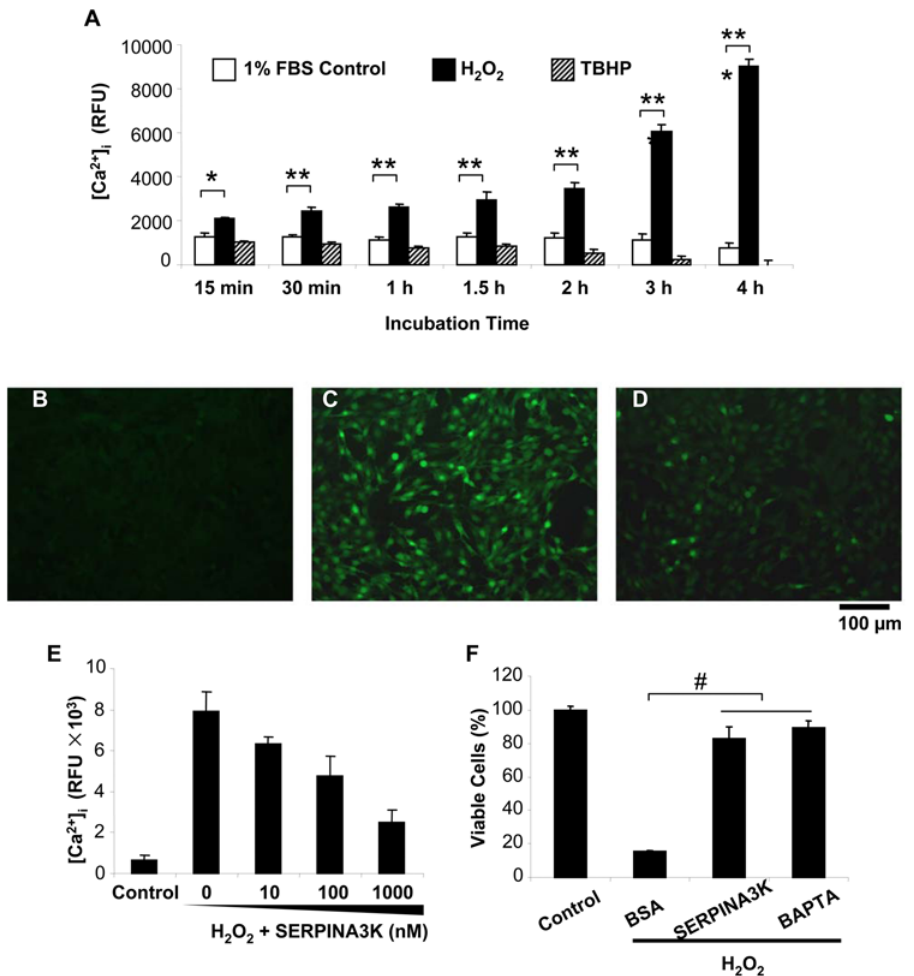
Figure 4. SERPINA3K blocks intracellular calcium overload induced by H 2 O 2 . ( A ) Elevated intracellular [Ca 2 + ] in cells exposed to H 2 O 2 . The Mu¨ller-derived rMC-1 cells were treated with 400 m M H 2 O 2 for various durations as indicated. TBHP (20 m M) was used as control. Intracellular [Ca 2 + ] was measured by the fluorescence of the probe Fluo-4/AM (mean 6 SEM, n=8). ( B–E ) The cells were pre-treated with 1 m M SERPINA3K or BSA for 1 h followed by the H 2 O 2 exposure. BSA was added to bring the total protein concentration to the same in each well. Representative fluorescence images were captured under a fluorescent microscope from untreated cells ( B ), cells pre-treated with 1 m M BSA ( C ) and with 1 m M SERPINA3K ( D ) followed by a 3-h exposure to H 2 O 2 . ( E ) [Ca 2 + ] in cells pre-treated with various concentrations of SERPINA3K prior to the exposure to H 2 O 2 (mean 6 SEM, n=6). ( F ) The protective effects of 1 m M SERPINA3K and 10 m M BAPTA/AM (a calcium chelator) were quantified using the MTT assay (mean 6 SEM, n=3). * P , 0.05, ** P , 0.01, *** P , 0.001, the cells treated by H 2 O 2 versus the control cells. # P , 0.01, the SERPINA3K or BAPTA-treated cells versus the BSA- treated cells. Scale bar, 100 m